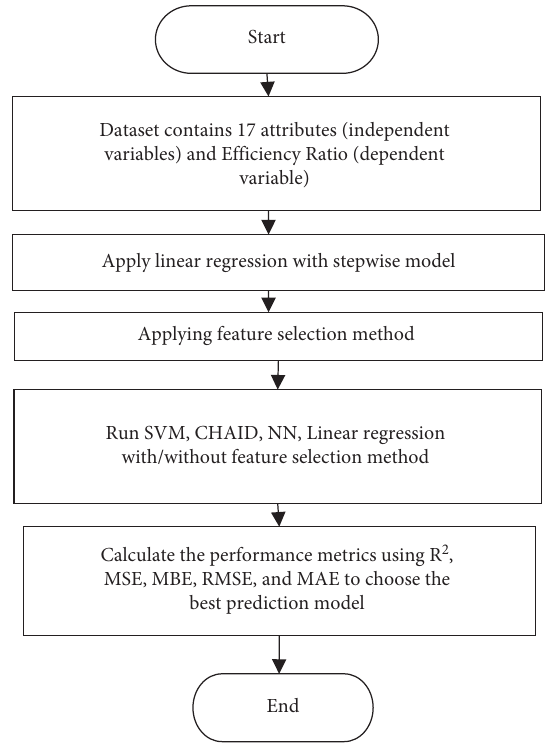
Figure 1: Steps of the